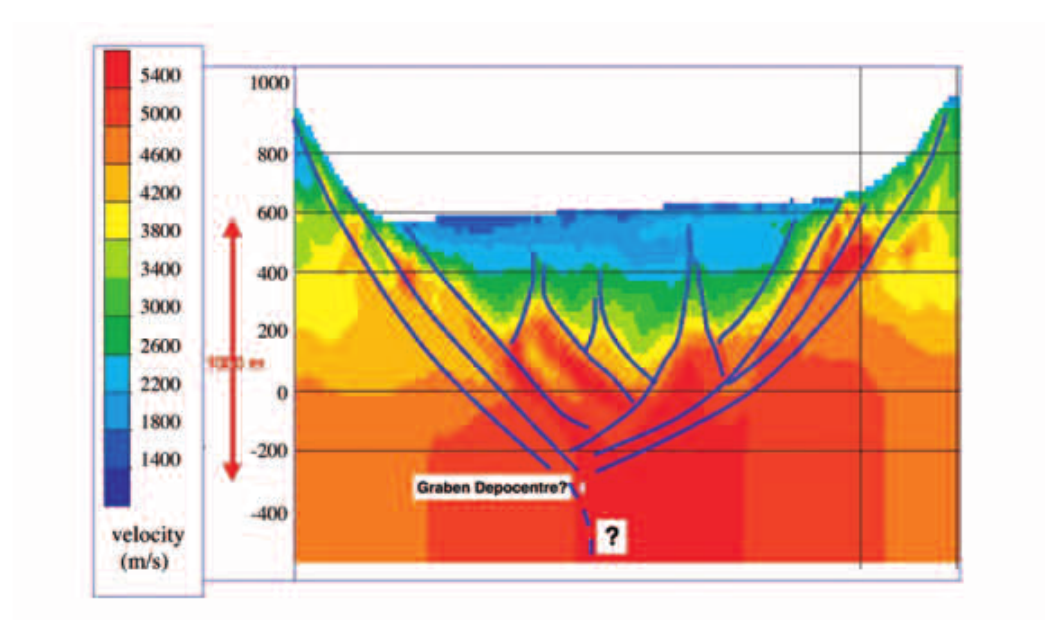
Fig. 13. Near tomography velocity – depth section – structural interpretation of the Val d’Agri graben.